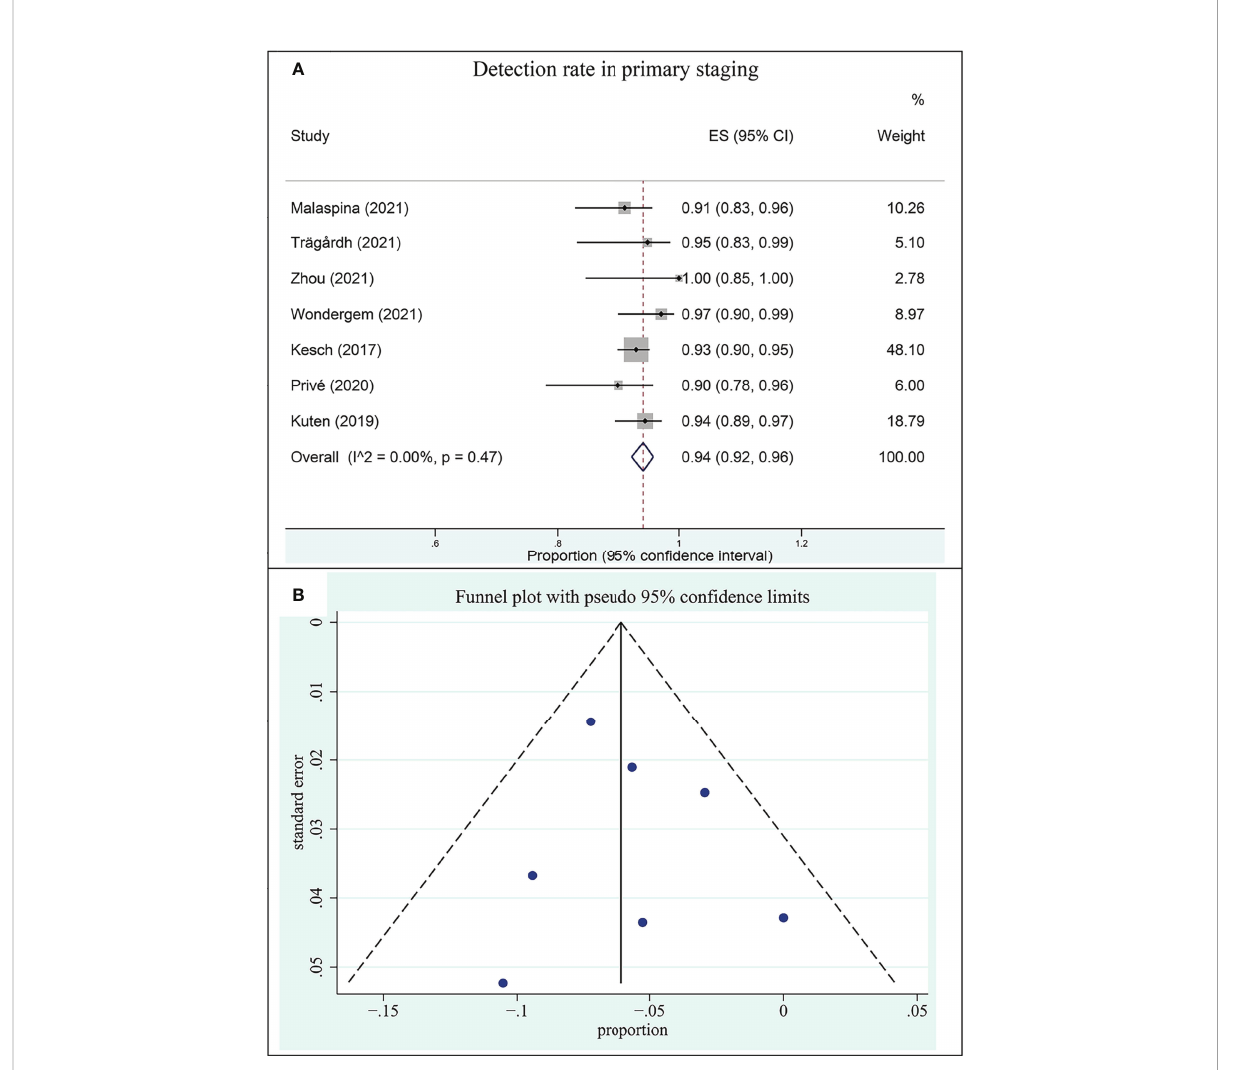
FIGURE 3 Plot of the pooled detection rate of 18 F-PSMA-1007 PET/CT for prostate cancer in primary staging (A) and related funnel plot for publication bias assessment ( B